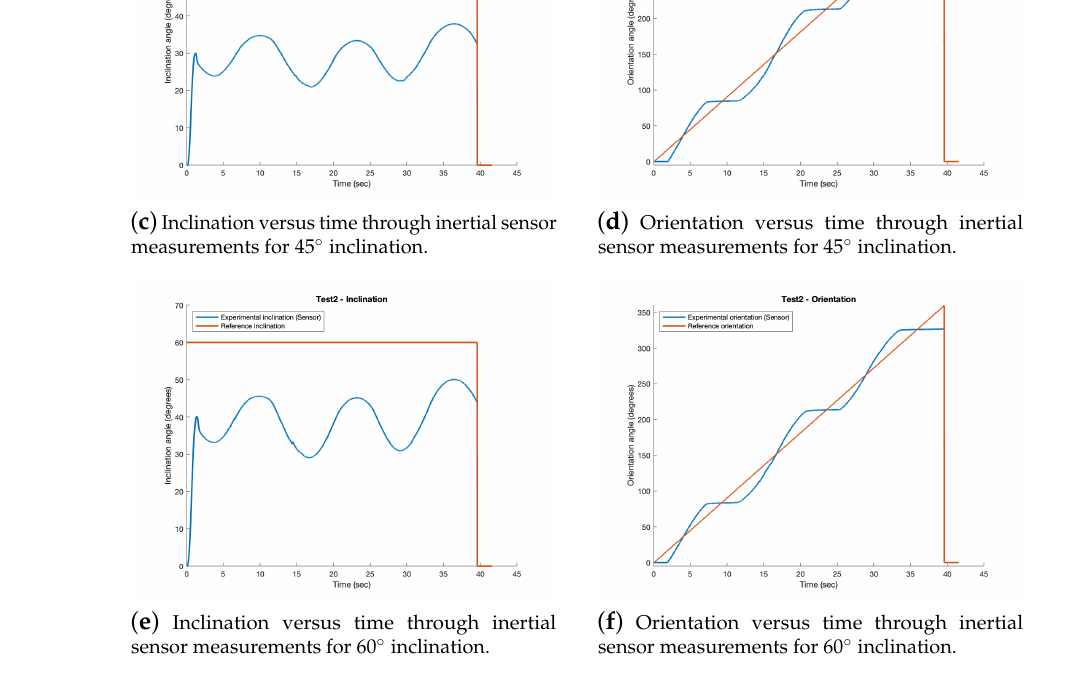
Figure 21. Test 2—Sensor data. Fixed 30 ◦ , 45 ◦ and 60 ◦ inclination for a 360 ◦ rotation. The blue line is the experimental data obtained from the encoder and the orange dotted line is the